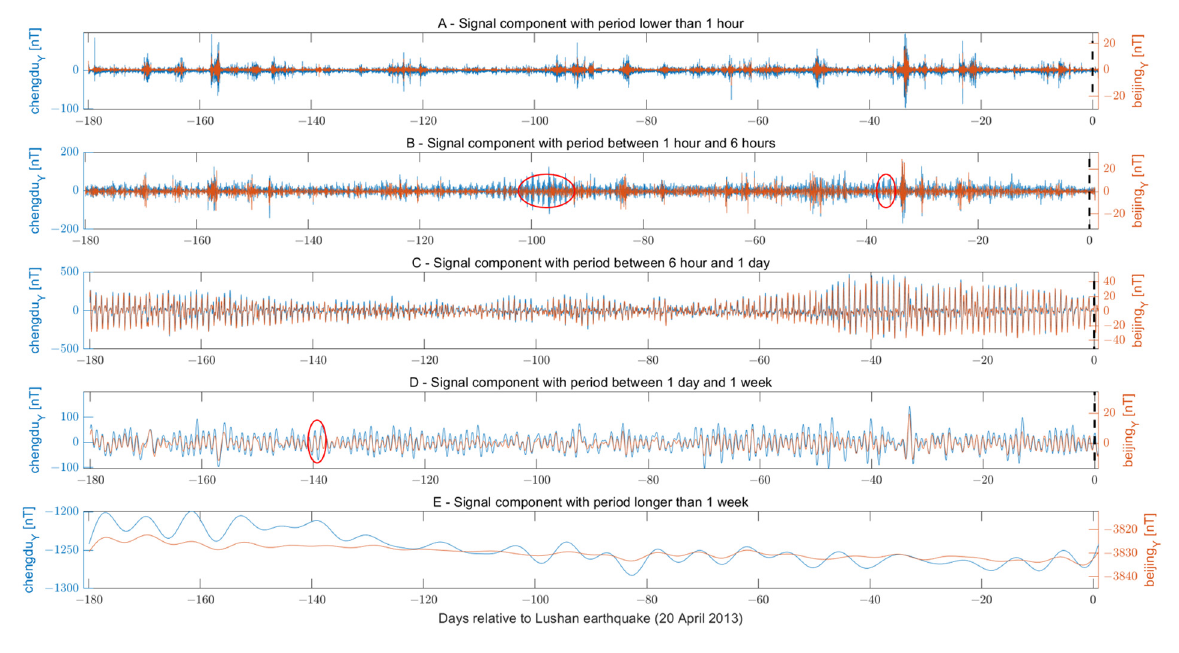
Figure 10. Y (East) component of geomagnetic data from CDP (Chengdu, blue lines) and BMT (Beijing, orange lines) ground observatories. The data were filtered into five frequency bands. The red ovals highlight more signals from the Chengdu observatory with respect to the Beijing observatory.